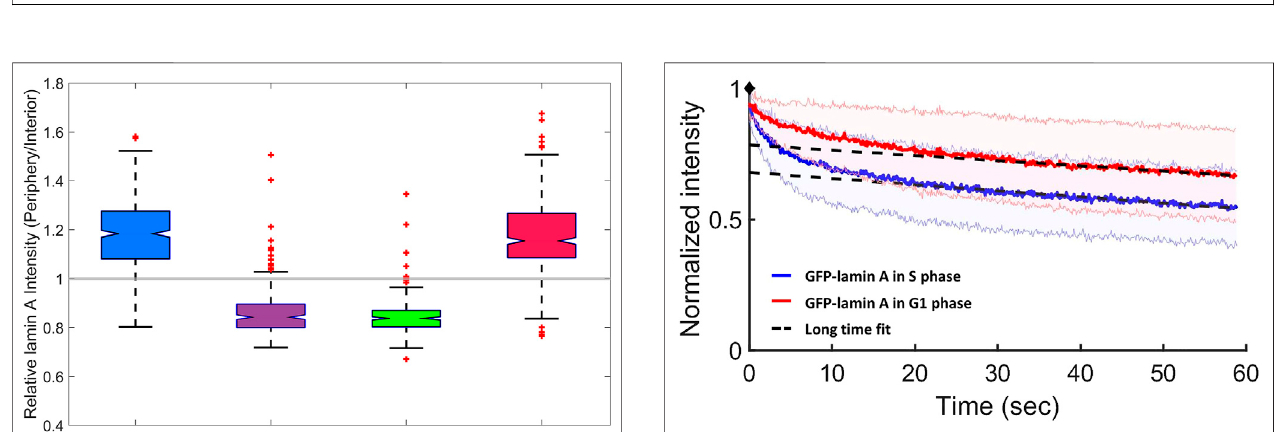
FIGURE 4 | Spatial correlations of lamin A with chromatin and tubulin. Left: Histograms of the overall positive and negative correlation coef fi cient of lamin A – chromatin (blue), and lamin A – tubulin (red) shown for different phases throughout the cell cycle. Right: The mean correlation coef fi cient of lamin A – chromatin (blue) and lamin A – tubulin (red) throughout the cell cycle. It emphasizes the trendline of the correlation during the cell cycle. Data were derived from ∼ 1200 MEF cells in interphase and ∼ 100 – 170 MEF cells in each of the mitotic phases.